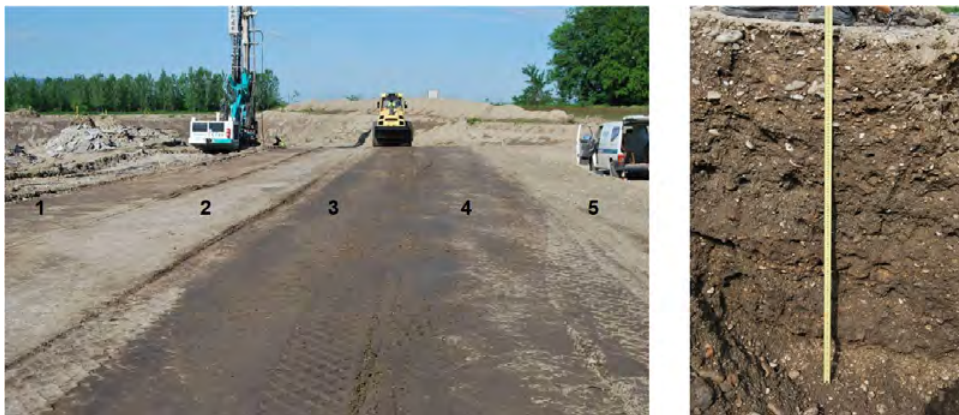
Figure 20. Vibratory roller during compaction on one of the test fields (left) and a view to the control pit in one of the test layers (right).